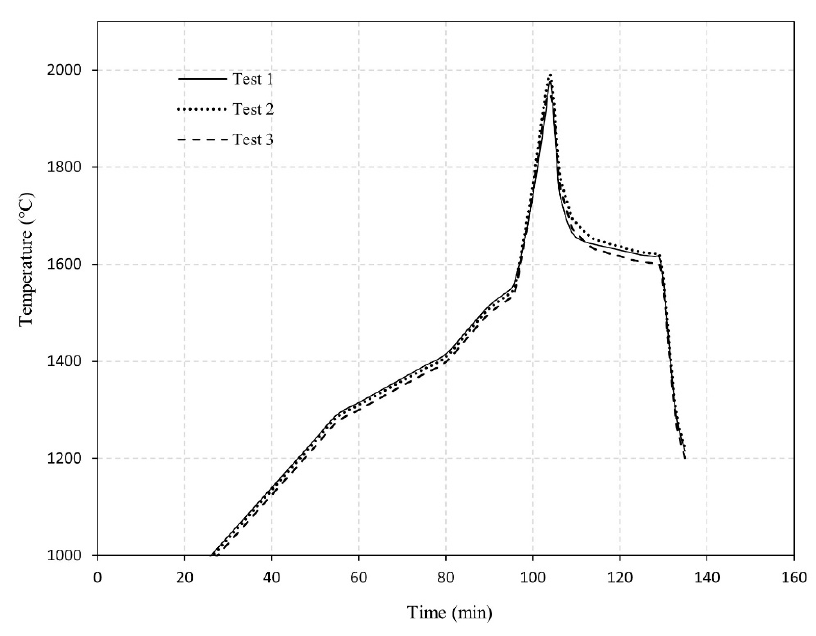
Figure 3. Typical temperature changes in the smelting-aluminothermic reduction of MnO + CaO mixture with Al metal.